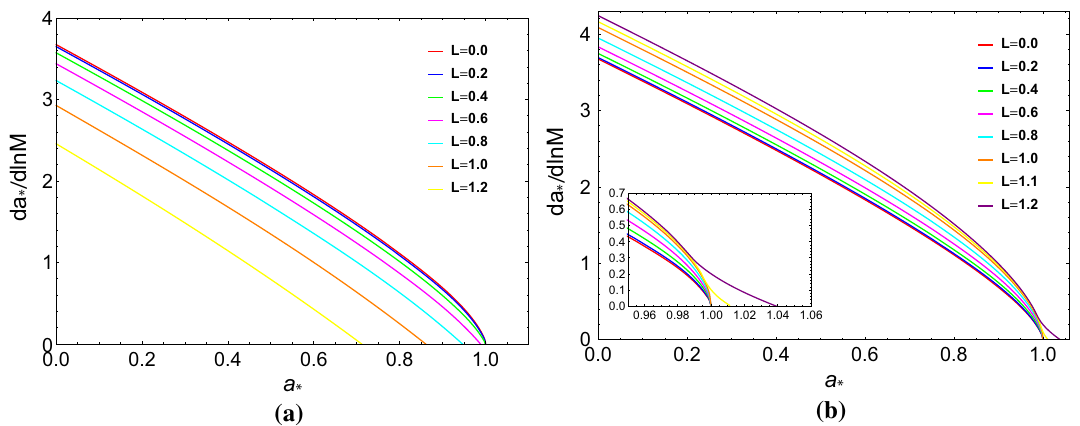
Fig. 4 da ∗ / d ln M as functions of the spin parameter a ∗ for different values of the parameter L for a regular and b singular black hole spacetimes. The inset in b shows the details near a ∗ = 1 decreases as L increases. We have also tried other regular rescaled metrics with different conformal factors, finding the same